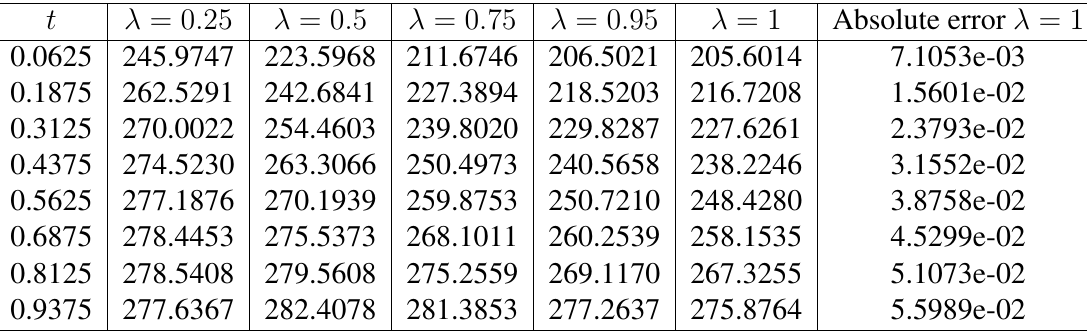
Table 1: The achieved absolute errors and numerical solutions of Example 4.1 using the proposed strategy for J = 2 and T = 1